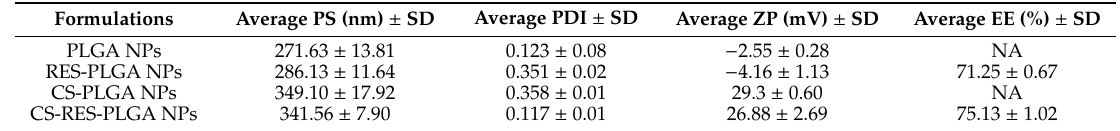
Table 1. Characterization parameters of optimized formulations.